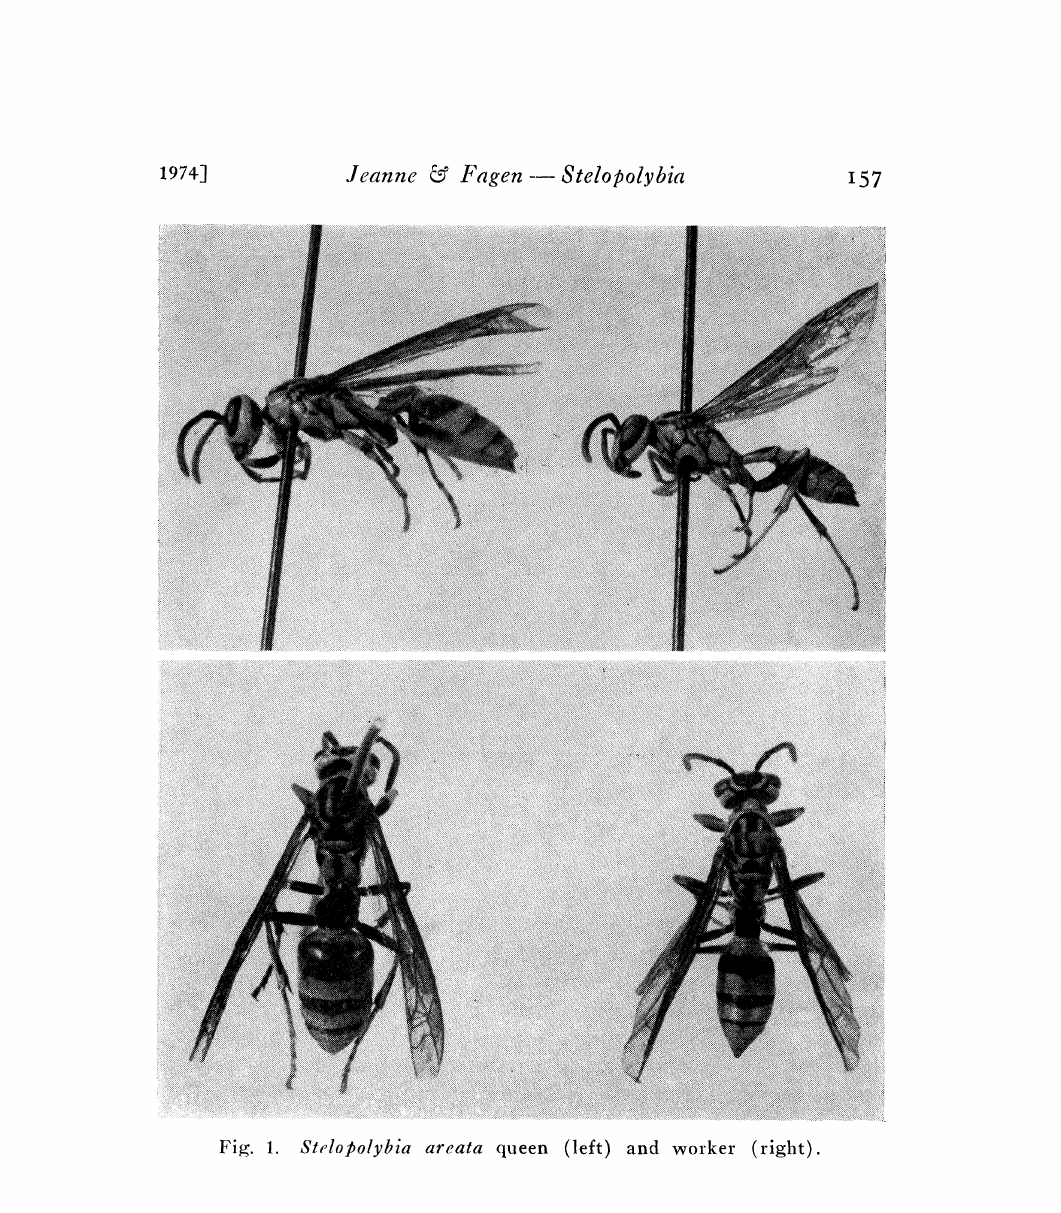
Fig. 1. Stelopolybia areata queen (left) and worker